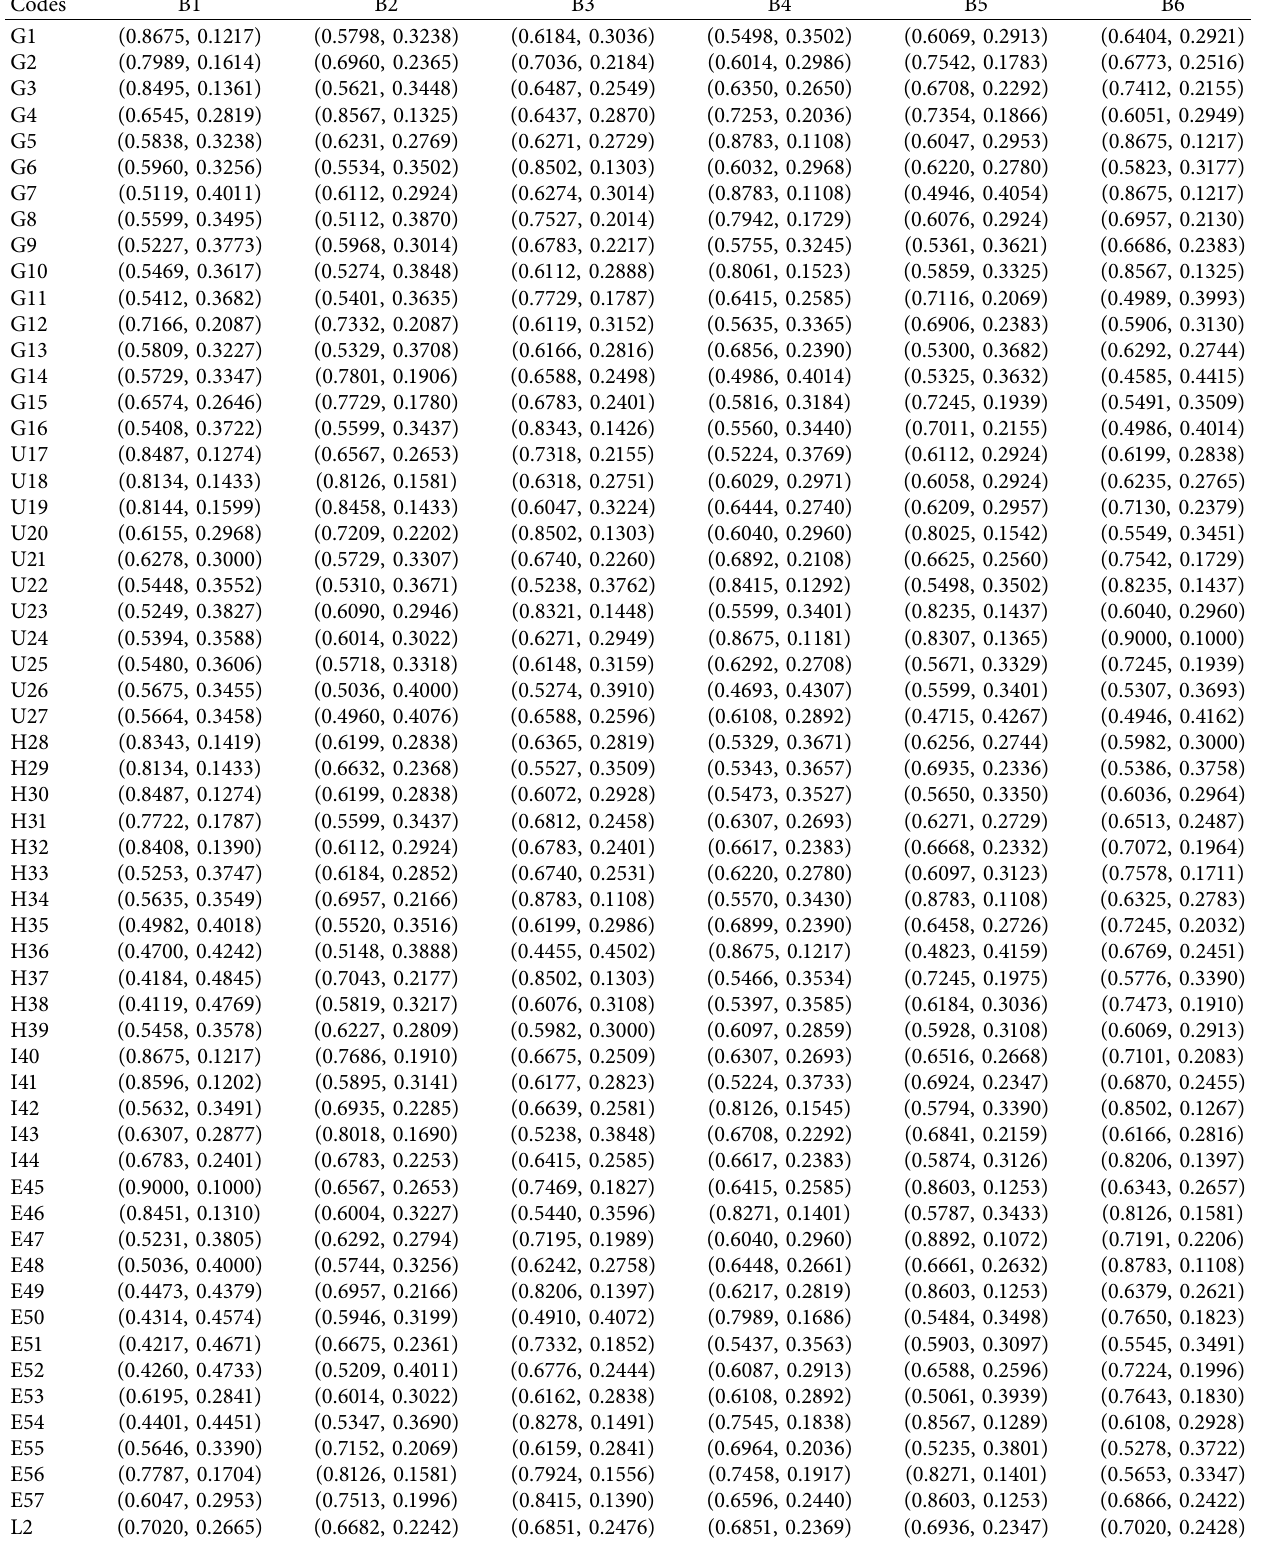
Table 9: Augmented FF decision